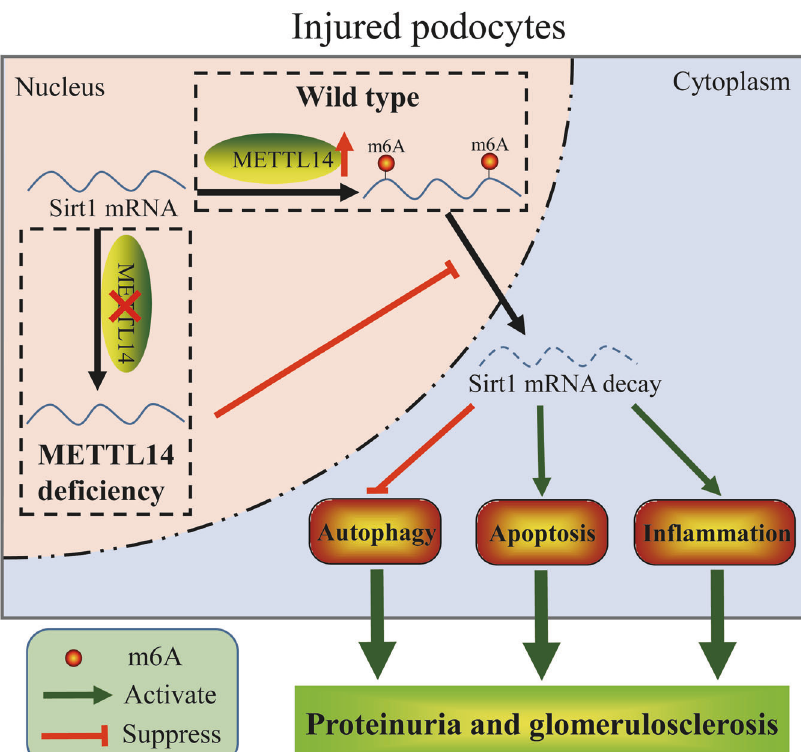
Fig. 8 Proposed schematic depicting the mechanism of METTL14 de fi ciency in alleviating podocyte injury. Podocyte injury upregulates the expression of METTL14, which results in the elevation of Sirt1 mRNA m6A modi fi cation and degradation. METTL14 knockdown leads to the inhibition of Sirt1 mRNA m6A modi fi cation, thereby increasing Sirt1 levels in injured podocytes. The upregulation of Sirt1 levels fi nally results in the activation of autophagy and the reduction of apoptosis and in fl ammation in podocytes, consequently alleviating proteinuria and delaying progression of